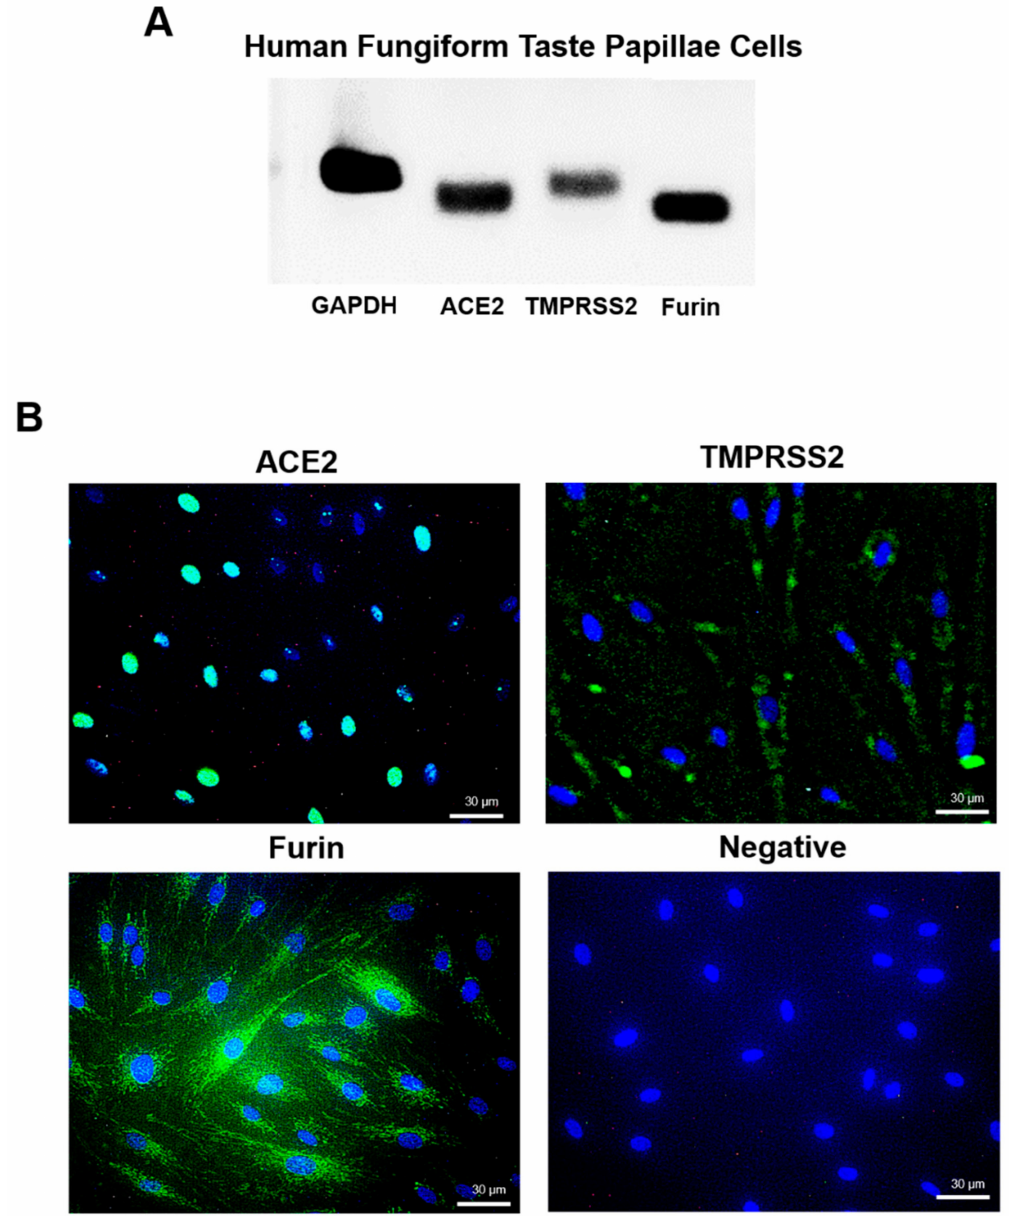
Figure 6. Expression and localization of ACE2, TMPRSS2, and furin mRNA and protein in human fungiformpapillaetastecells. ( A )RT-PCRanalysisshowingglyceraldehyde3-phosphatedehydrogenase (GAPDH), ACE2, TMPRSS2, and furin in human fungiform papillae taste cells. ( B ) Immunochemical staining for ACE2 (green), TMPRSS2 (green), furin (green), and the nucleus (blue) in human fungiform papillae taste cells. The negative control section was stained with non-immunized rabbit IgG. Scale bar = 30 µ m. ACE2, angiotensin-converting enzyme 2; TMPRSS2, transmembrane protease serine